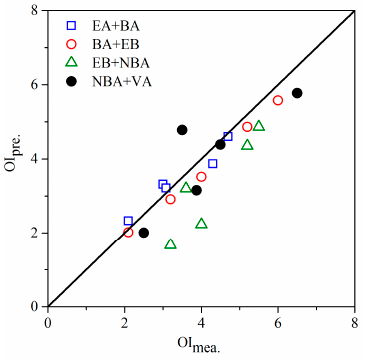
Figure 3. The comparison between measured OI (OI mea. ) and predicted OI (OI pre. ) of binary ester mixtures (ethyl acetate, EA; butyl acetate, BA; ethyl butyrate, EB; n-butyl acrylate, NBA; vinyl acetate, VA). The solid line means a complete match.